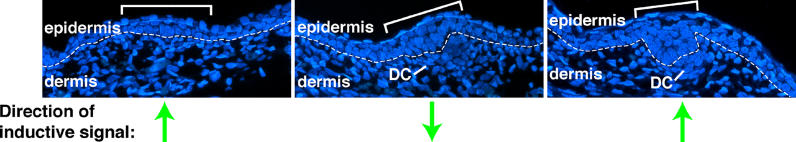
Successive Stages of Hair Follicle Development in Embryonic Mouse Skin at E14.5–E15.5Sections were stained with Hoechst dye to reveal the nuclei. The epithelial–mesenchymal boundary is marked by a dashed white line in each panel, and sites of hair follicle development are bracketed. The directions of inductive signals are indicated for each stage (green arrows). Left: placode stage; note larger size and columnar appearance of placode nuclei compared with those in adjacent epithelium. Middle: induction of the dermal condensate (DC). Right: formation of a germ stage hair follicle with a well-developed dermal condensate.